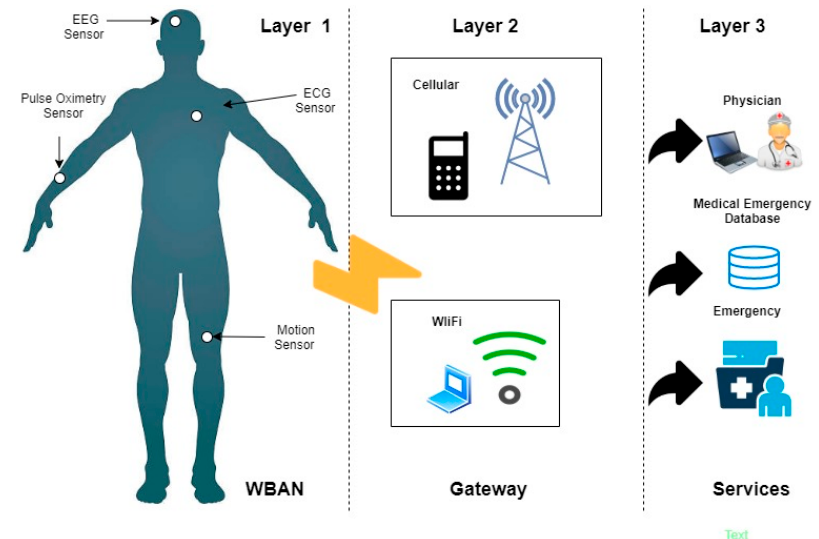
Figure 1. General WBAN Architecture.